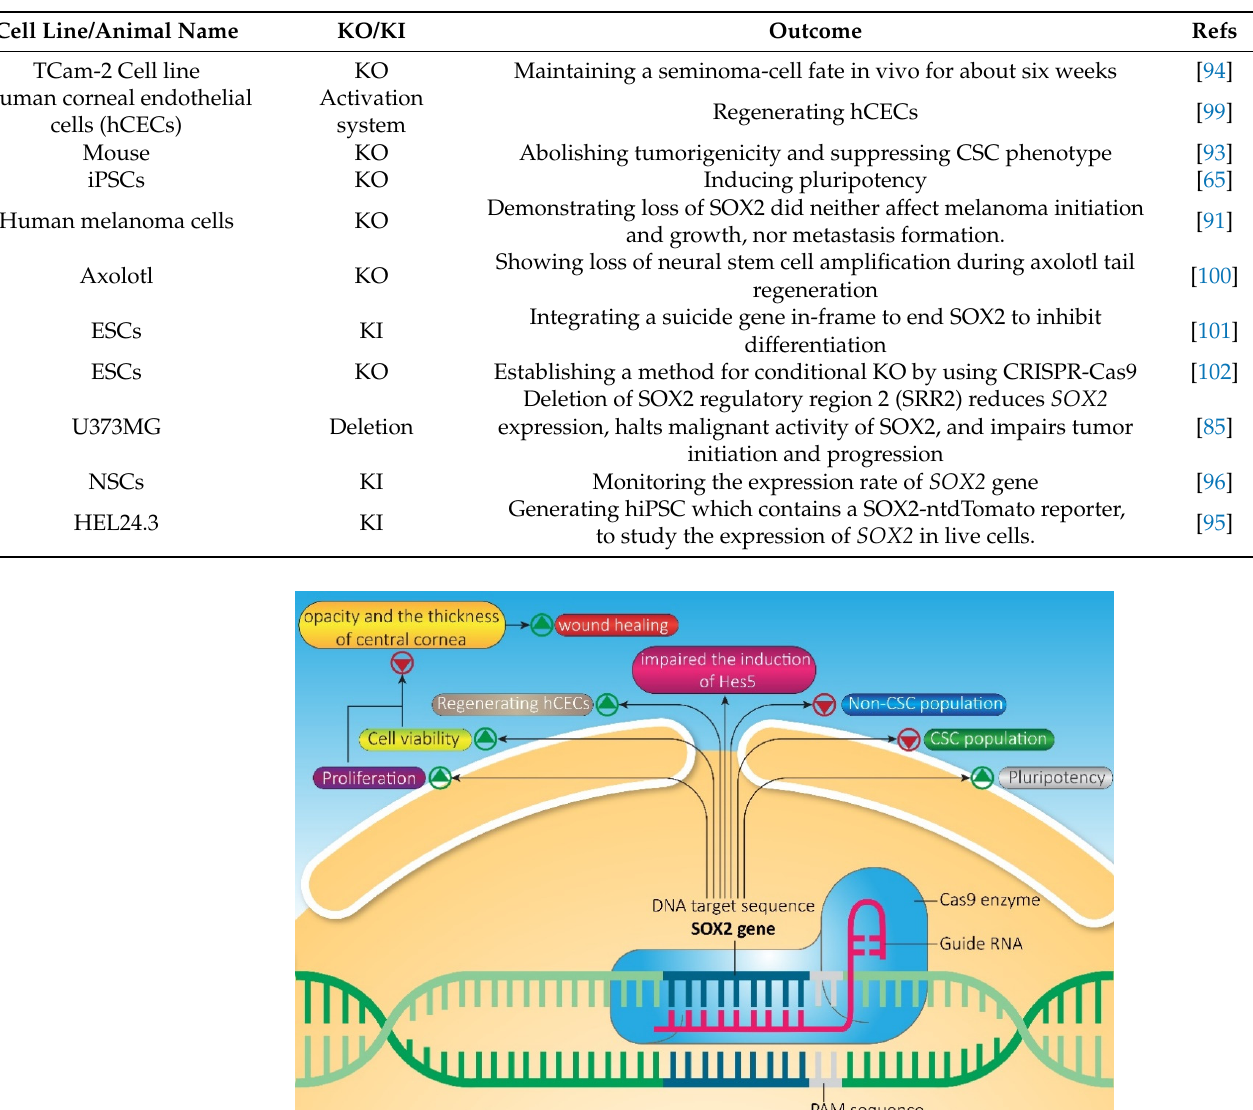
Table 1. CRISPR targeting SOX2 .